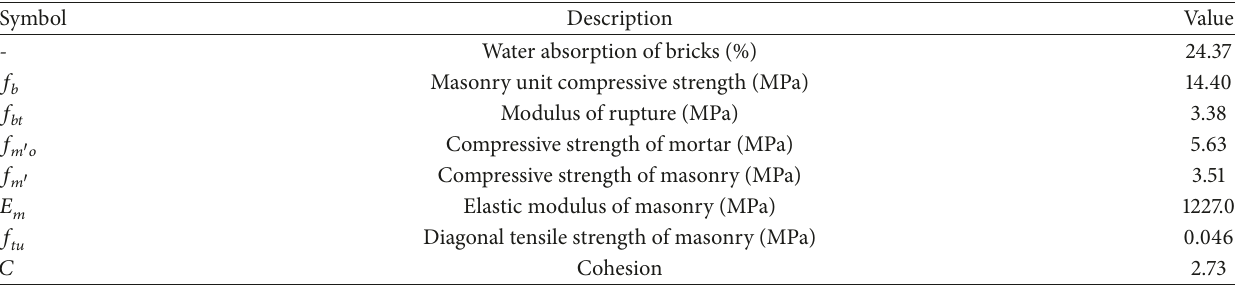
Table 1: Material properties.